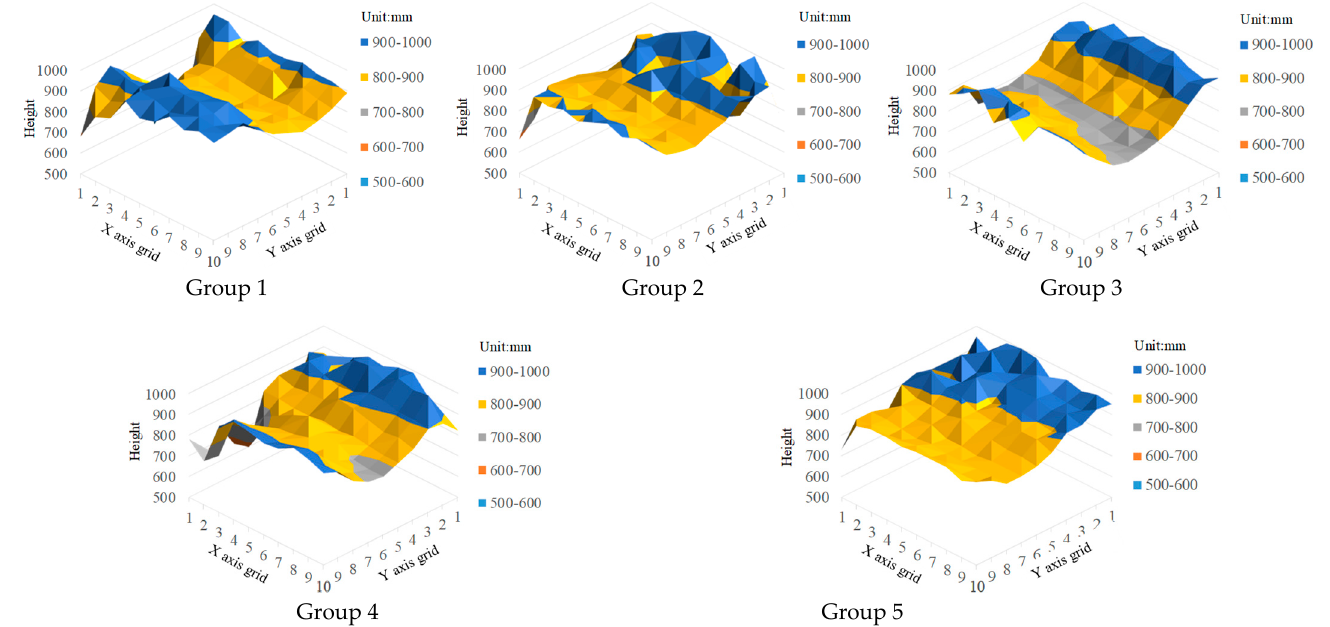
Figure 9. Estimation of plant height distribution in rice.